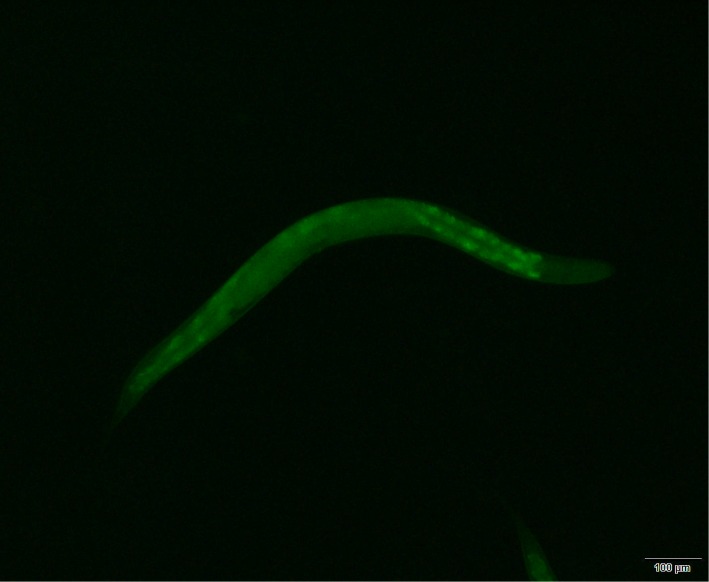
Fluorography of the colonization model (Magnification, 100×).